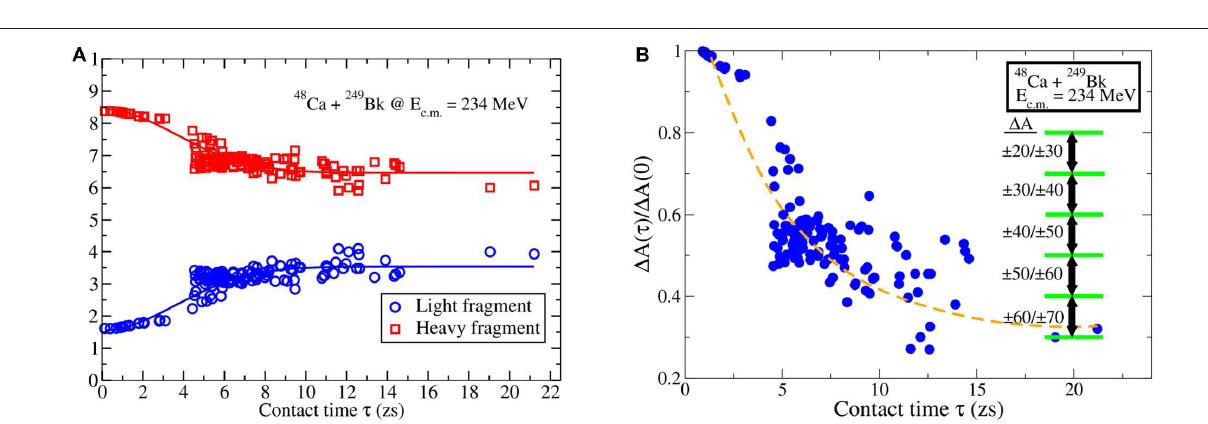
Frontiers in Physics |